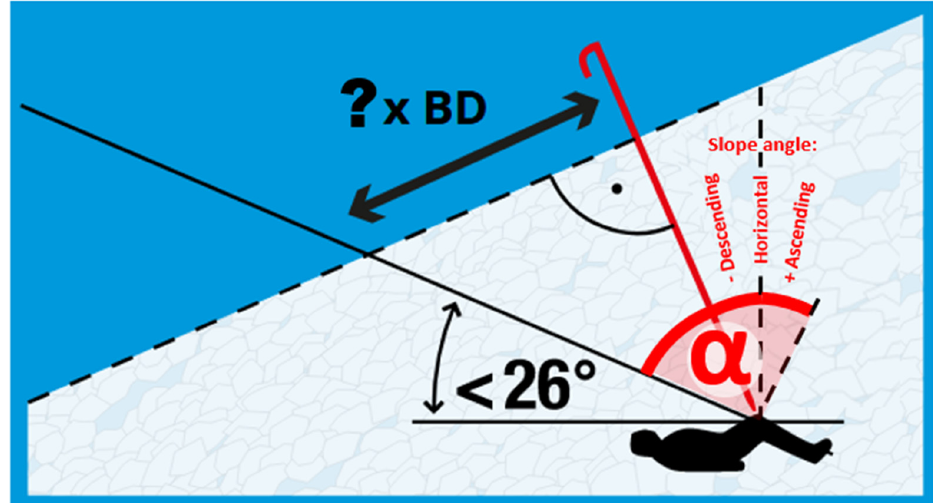
Figure 5. Required length of the snow conveyor belt (tan α ) relative to slope inclination. The ramp angle of the snow conveyor belt must remain lower than 26° to prevent the snow to keep falling back towards the probe (empiric field test data [16]) and thus to ensure an efficient excavation effort. Illustration: www.MountainSafety.info as of 31 December 2021, reprinted with permission of www.MountainSafety.info.